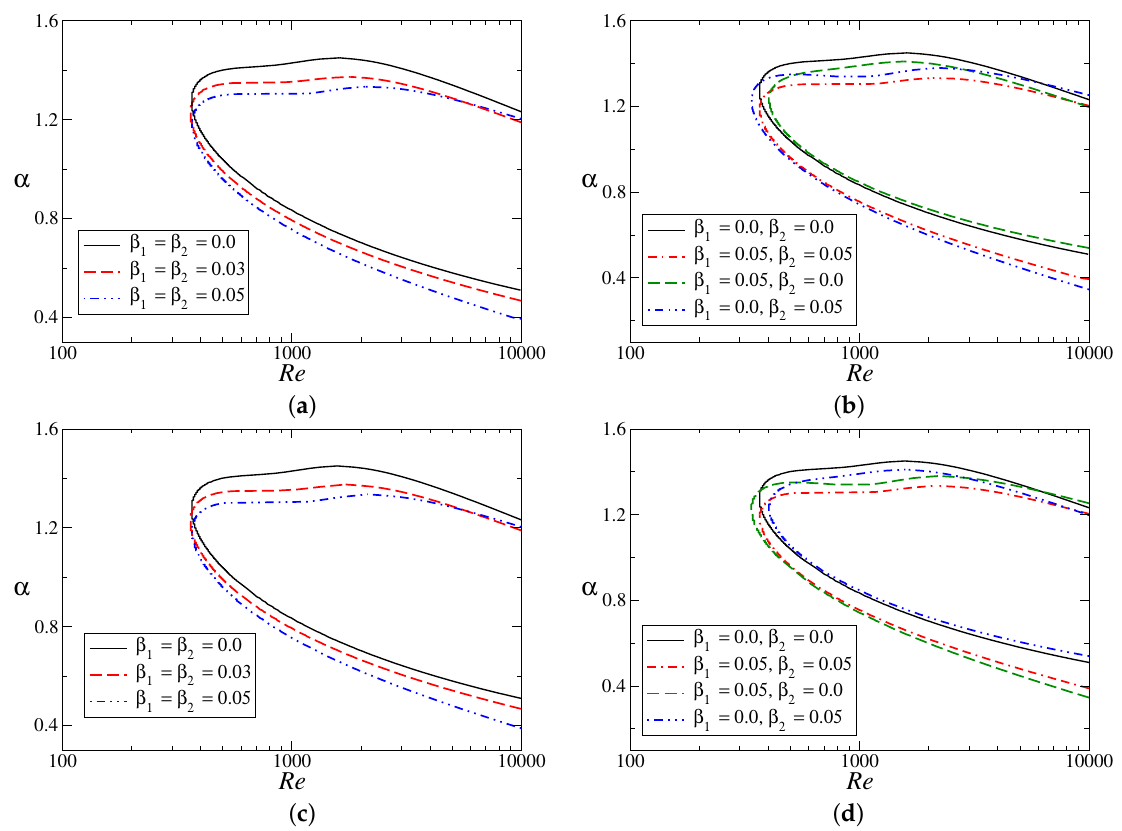
Figure 8. Neutral stability curves: ( a , b ) σ 1 = 0.5, σ 2 = 0.2; ( c , d ) σ 1 = − 0.5, σ 2 = 0.2. ( a , c ) Symmetric slip; and ( b , d ) non-symmetric